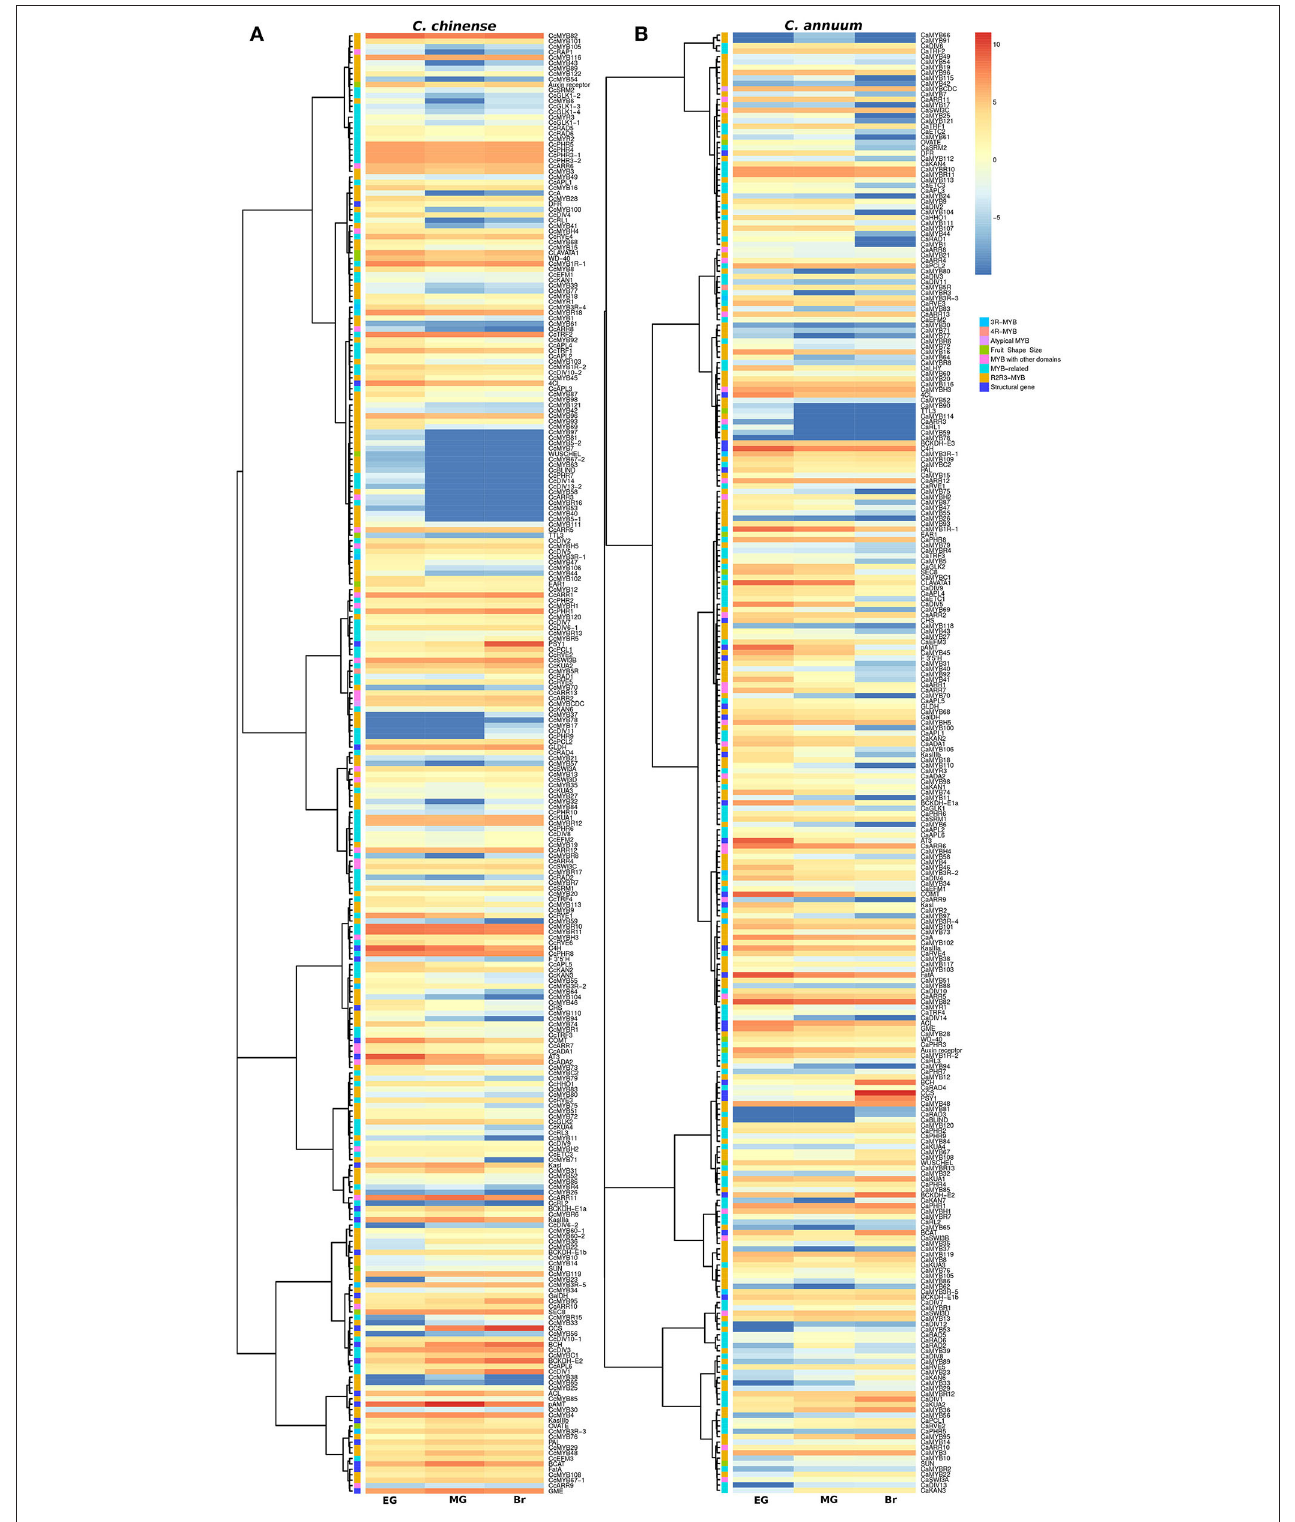
FIGURE 5 | Expression profiles of MYB genes in (A) C. chinense , (B) C. annuum at the three different fruit developmental stages. The heatmap color scale represents the log2 fragments per kilobase of transcript per Million mapped reads (FPKM) expression of MYB genes.